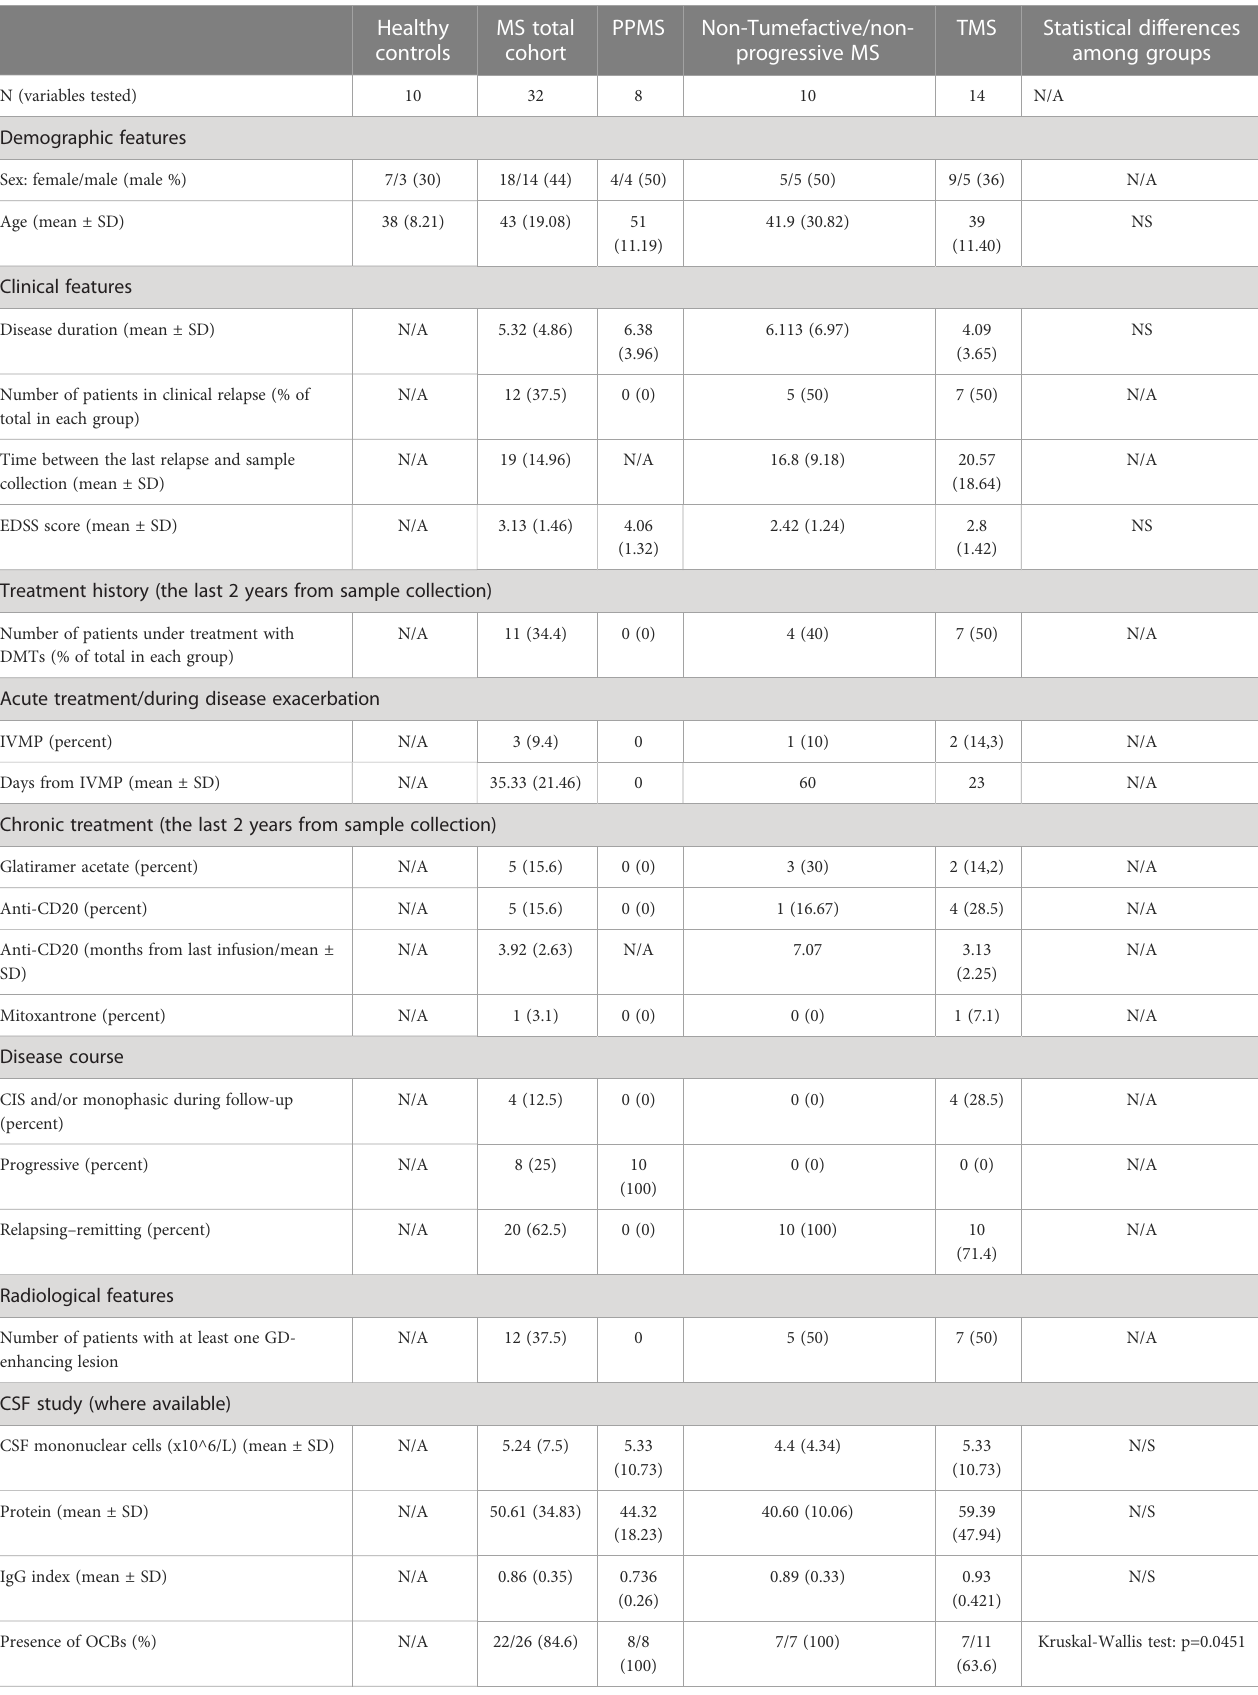
TABLE 1 Main characteristics (clinical, radiological, and laboratory) of the participants included in the